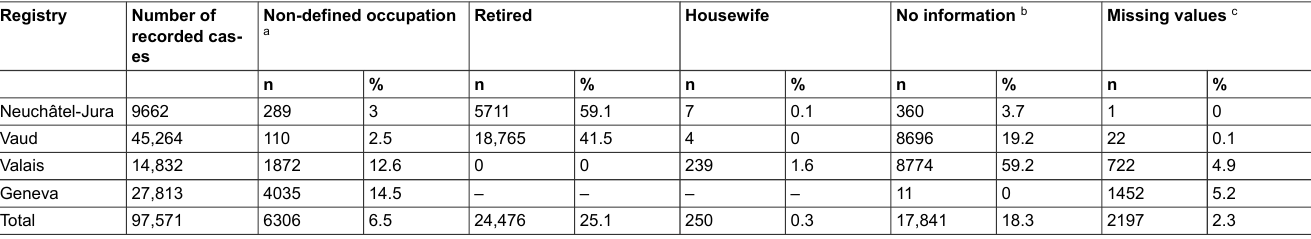
Table 2: Completeness of occupational information in cancer registries of Western Switzerland between 1996 and 2004. Registry